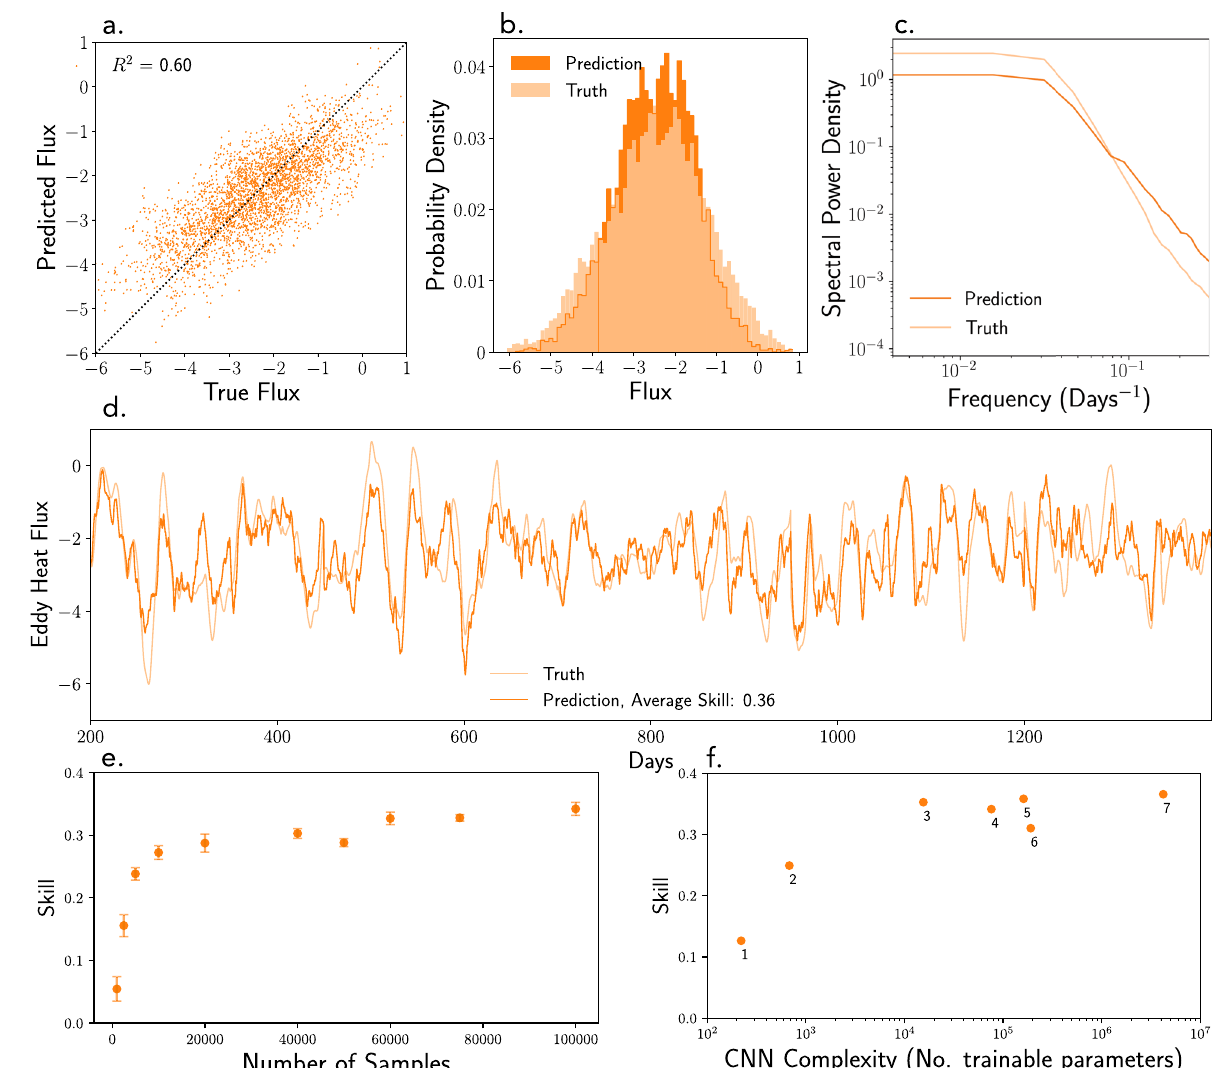
Fig. 3 Performance of convolutional neural networks in estimating instantaneous domain-averaged eddy heat fl uxes from SSH snapshots. Panels a – d show comparisons between the predictions (dark orange) and the true values (light orange) for various performance diagnostics. a Scatter plot of predictions for the validation dataset demonstrating that convolutional neural networks explain over 60% of the fl ux variance (max achieved R 2 = 0.64). b Histograms highlighting the prediction biases towards underestimating extreme values of eddy fl uxes. c Power spectra highlighting the prediction biases towards producing noisier time series at frequencies higher than O(0.1 days − 1 ). d Time series showing the fl uctuations of the true and predicted eddy heat fl uxes, highlighting the skill and relative temporal smoothness of the prediction as well as its de fi ciencies on individual events. The eddy heat fl ux prediction is plotted for the network state with maximum validation skill (skill metric de fi ned in Methods), corresponding to a test data skill of 0.36. e Sensitivity of the fully trained convolutional neural network skill on the number of data samples used for training; error bars represent a range in the validation skill corresponding to the top 100 best training skills. f Prediction skills achieved for a variety of convolutional neural network (CNN) architectures ranging from simplistic to deep; the number of adjustable parameters is shown on the x-axis as a rough measure of CNN complexity while hyperparameters are referred to by numbers and described in We do not observe divergent over fi tting over the full training period of 100 epochs. For small values of x , or when the HFD boundary is close to the edge of the SSH subdomain, the CNN struggles to learn the HFD (Fig. 4c). The skill improves once the boundary inset x is increased, achieving an optimum when x ≈ 200 km from the edge of the subdomain (Fig. 4c). The